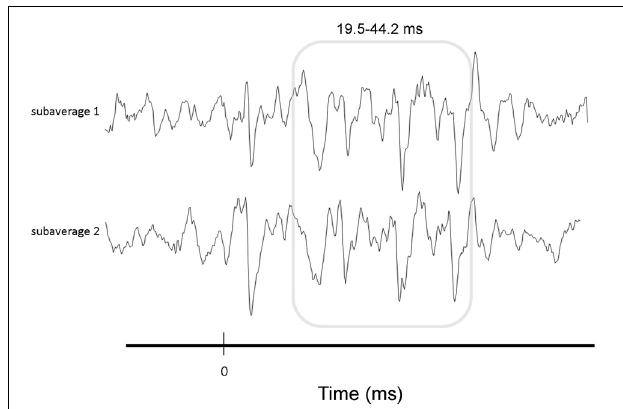
FIGURE 2 | Illustration of response consistency measure. To gauge the repeatability of the response over the course of the recording, two subaverages were collected and correlated. Correlations were performed over the FFR (19.5–42.2ms, gray